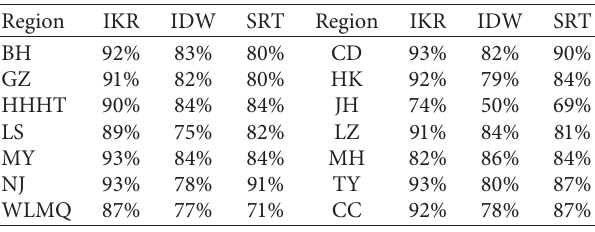
Table 3: Error detection rates under the best QC parameters in the 14 regions of the country.